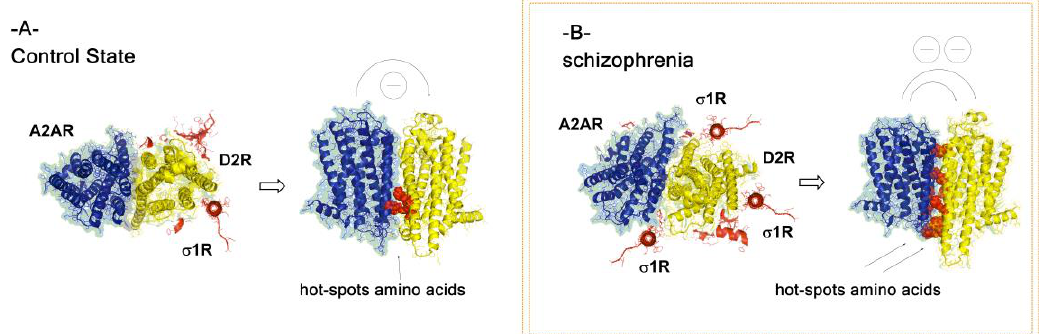
Figure 2. Proposed alterations of A 2A -D 2 -Sigma1 heteroreceptor complexes in nucleus accumbens in schizophrenia. ( A ) A 2A -D 2 -Sigma1 higher-order heteroreceptor complexes given in a control state. The adaptor protein Sigma1receptor is given in red. ( B ) In schizophrenia there may develop an